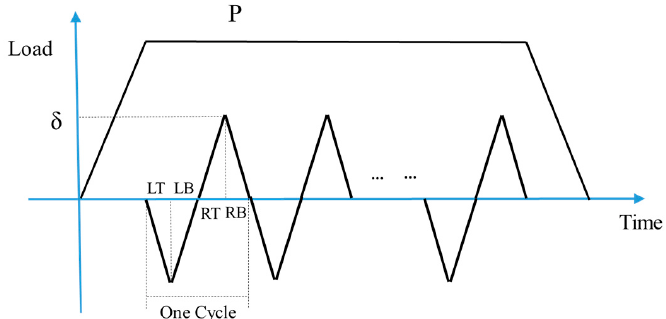
Figure 7. Loading history of FE model.